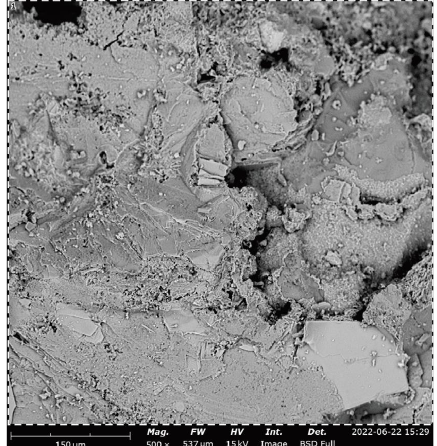
Figure 27: SEM for M1 sample room temperature.